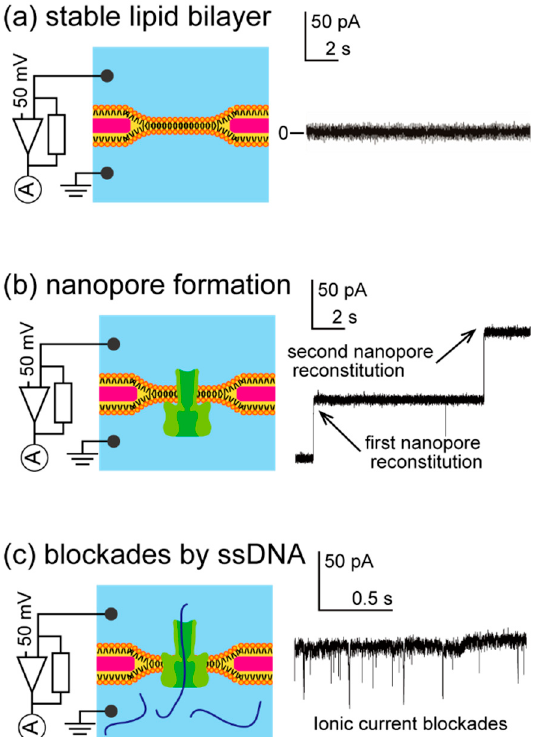
Figure 8. Ionic current traces with the mini-cup device. ( a ) Lipid-bilayer formation. ( b ) Reconstitution of nanopore proteins in a formed lipid bilayer. The reconstitution resulted in a stepwise increment of approximately 50 pA. ( c ) Blockades of ionic current by ssDNA. The interaction between the nanopore and ssDNA partially and temporarily blocked the open-pore current. Applied voltage: 50 mV.